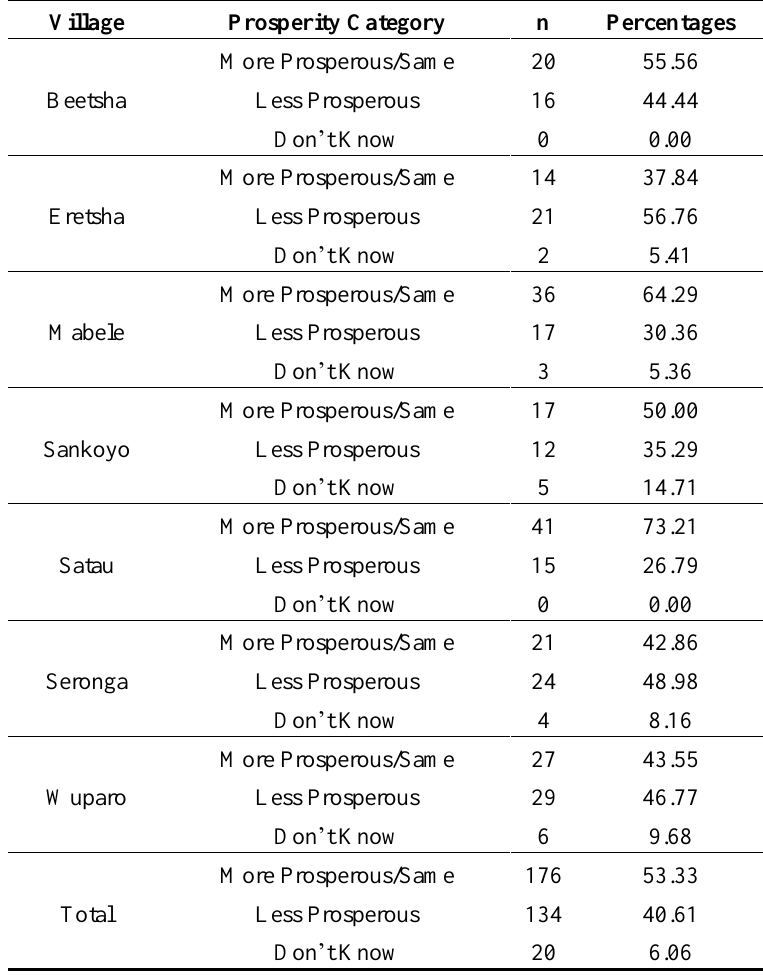
Table 7. Village prosperity comparison based on the survey question “Compared to five years ago are you more, less, or of the same